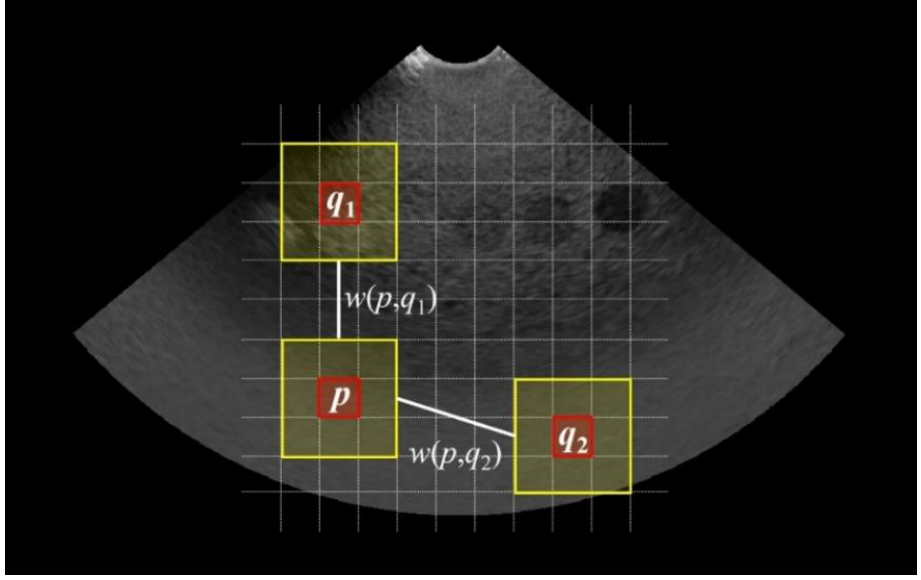
Figure 1. Description of weighting part during processing of NLM noise-reduction algorithm image. The weight was adjusted based on the Euclidean distance, and the standard deviation value ( δ ) was set to 20. Figure 2a,b show the original NLM denoised image and the corresponding residual image based on the default δ value,